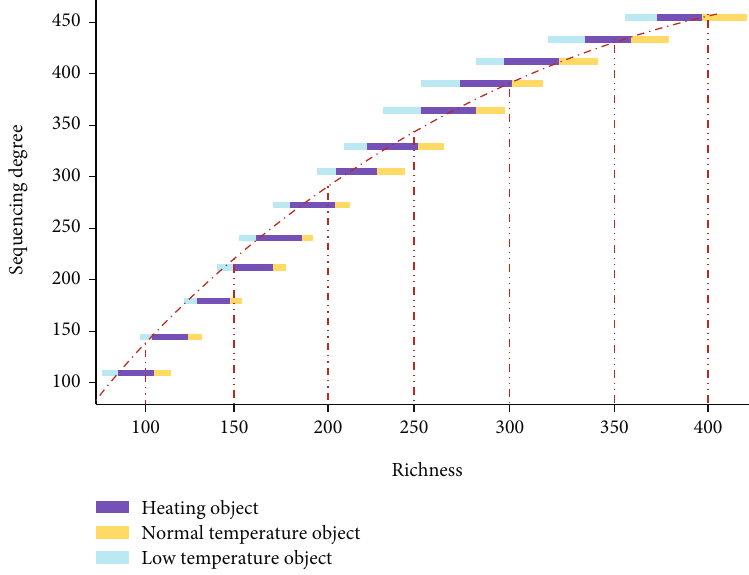
Figure 9: Richness changes of diversity sequences of experimental